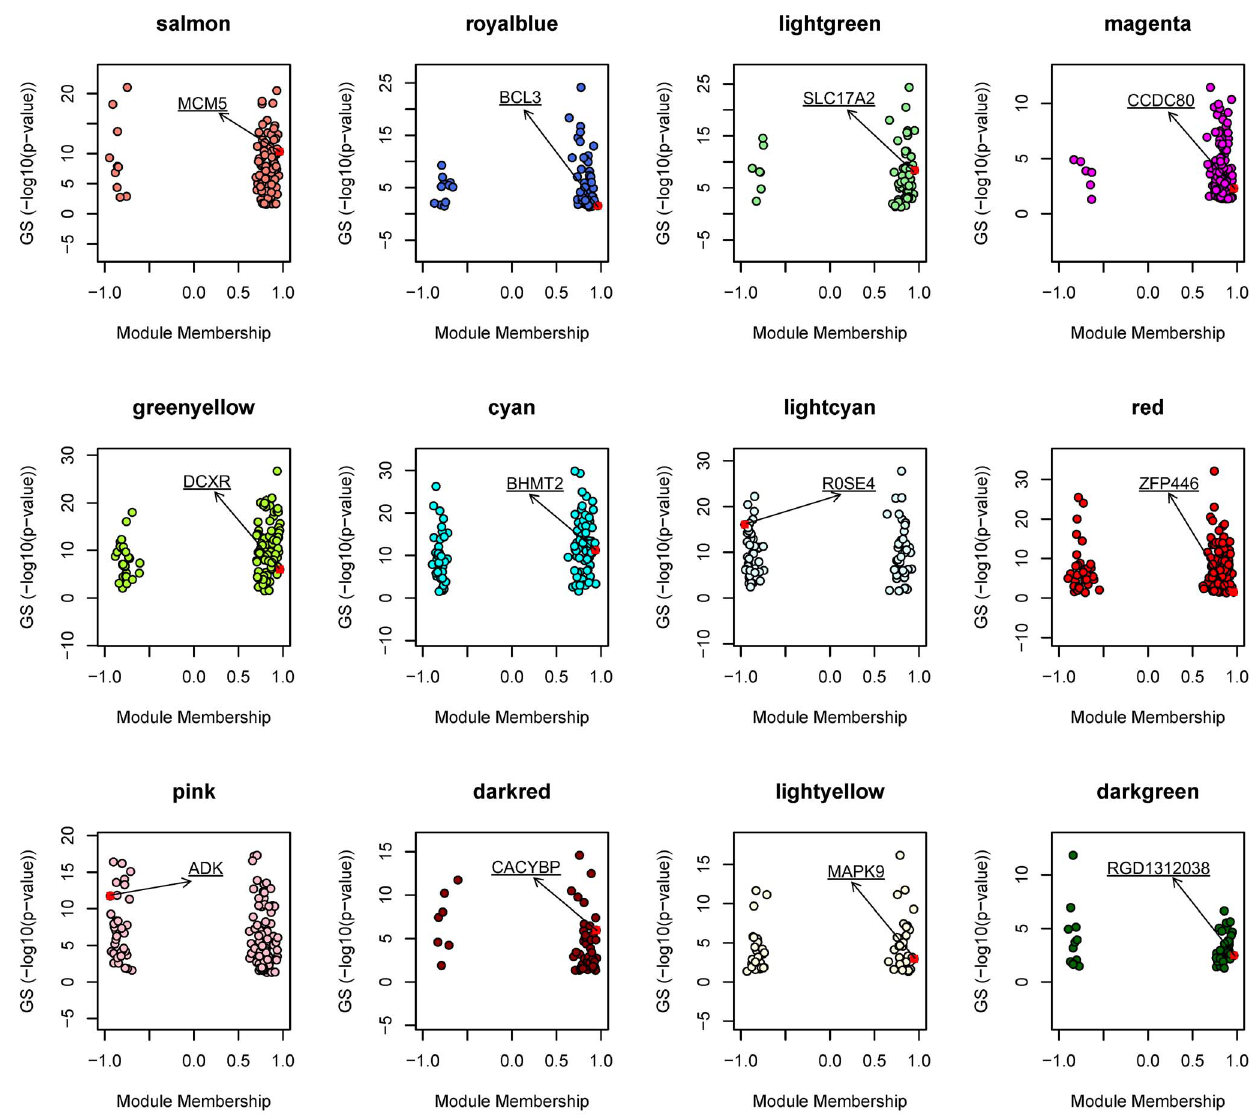
Figure 3. Correlation of Connectivity on the x-axis with gene significance on the y-axis and identification of hub genes based on high MM. The color represents the module and the dot represents the gene in the module. Red square represents hub gene in each module with highest connectivity. Hub gene symbol is underlined.